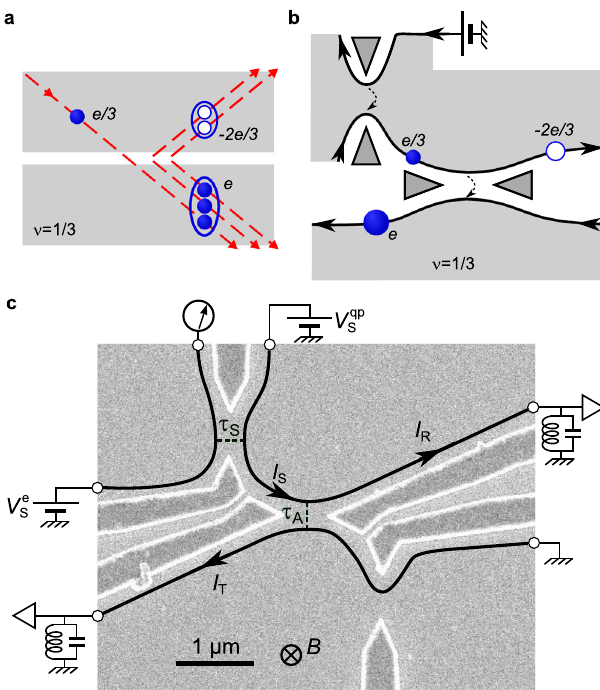
Fig. 1 | Quasiparticle Andreev re fl ection in a source-analyzer setup at ν =1/3. a Andreev mechanism. An incident e /3 quasiparticle is transmitted as an e quasie- lectron and Andreev re fl ected as a − 2 e /3 quasihole. The Andreev process can be pictured as the excitation of two e /3 quasiparticle-quasihole pairs and the incident quasiparticle bunching together. b Setup schematic in Andreev re fl ection con fi g- uration. The top-left `source ’ QPC is set in the weak back-scattering (WBS) regime and voltage biased from the top to emit e /3 quasiparticles toward the central `analyzer ’ QPC. The latter is tuned in the strong back-scattering (SBS) regime favoring the transmission of quasielectrons. c , Electron micrograph of the mea- suredGa(Al)Asdevice.Thecurrentpropagatesalongchiraledgechannelsshownas black lines. The gate de fi ned QPCs are tuned by fi eld effect. The source is biased with V qp S at V e S =0and1 − τ S ≪ 1( V e S at V qp S =0and τ S ≪ 1)toproduceadilutecurrent of quasiparticles I S = ð 1 (cid:3) τ S Þ V qp S = ð 3 h = e 2 Þ (of quasielectrons I S = τ S V e S = ð 3 h = e 2 Þ ). Setting V qp S = V e S allows for a direct voltage bias of the